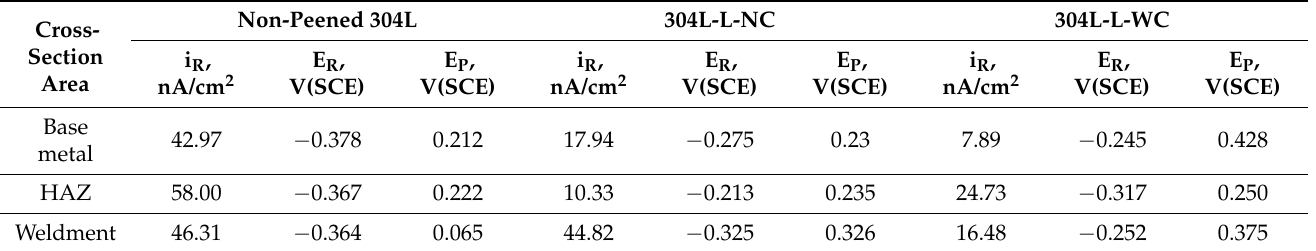
Table 7. The corrosion factors of the cross-section of 304L stainless steel obtained from Tafel extrap- olation.